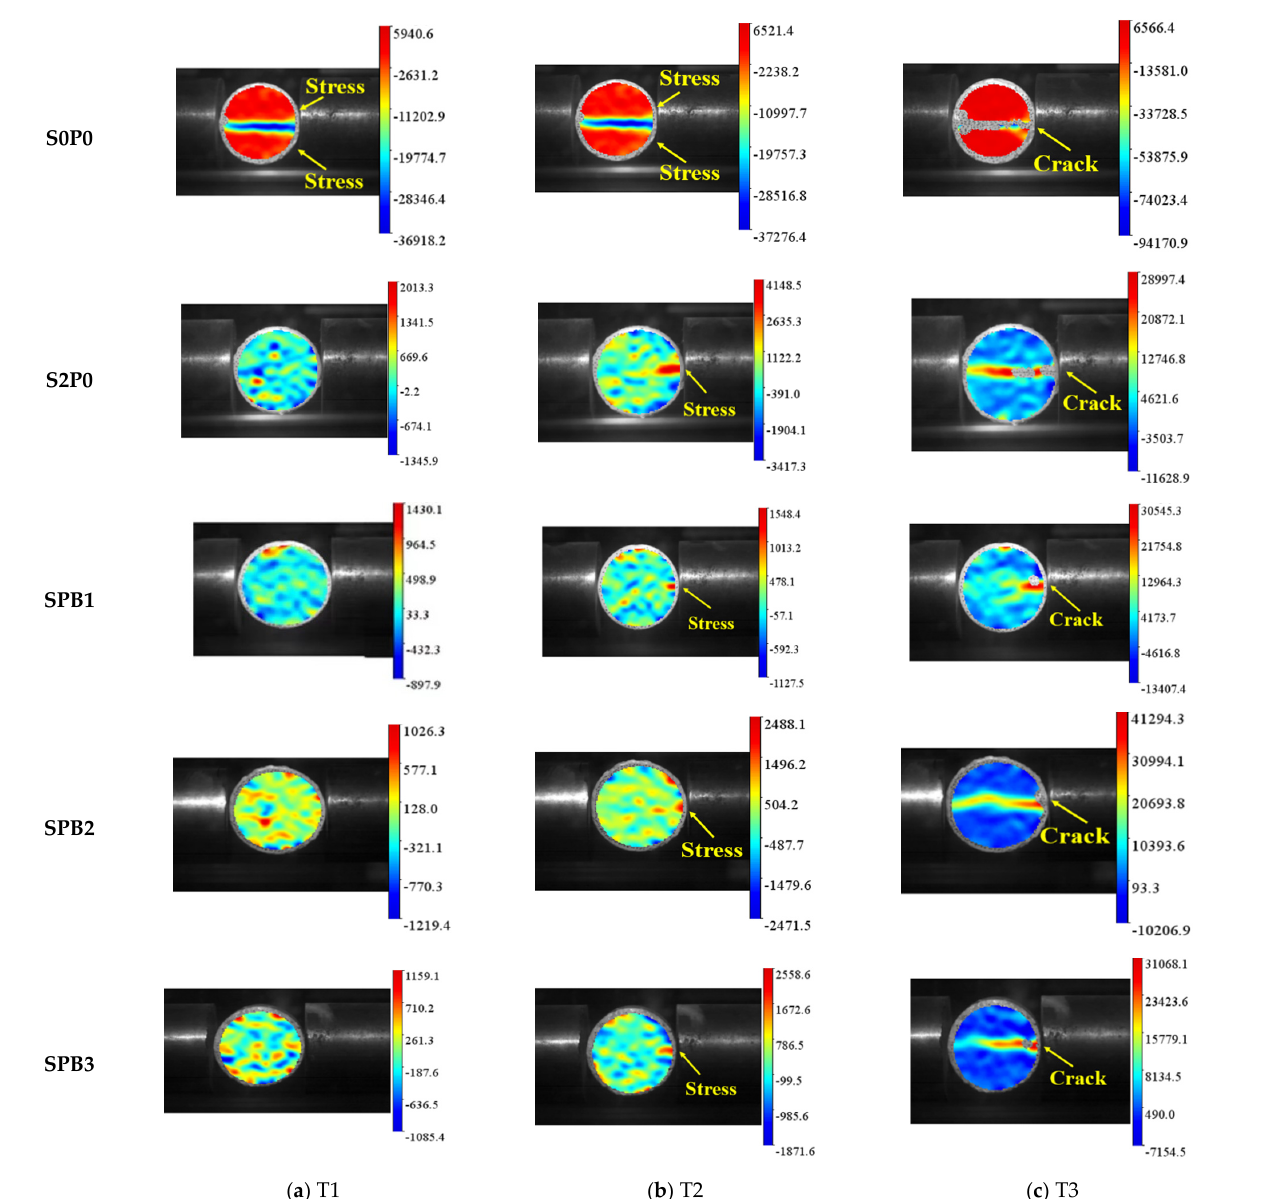
Figure 8. Strain distribution nephograms of each specimen at different times: ( a ) Strain-nephogram corresponding to the initial stress time of the specimen (i.e., T1); ( b ) strain-nephogram corresponding to the moment before the crack appeared in the specimen (i.e., T2); ( c ) strain-nephogram corresponding to the moment when the crack appeared in the specimen (i.e., T3). Table 8. The corresponding schedule of DIC strain nephograms for each group of specimens.